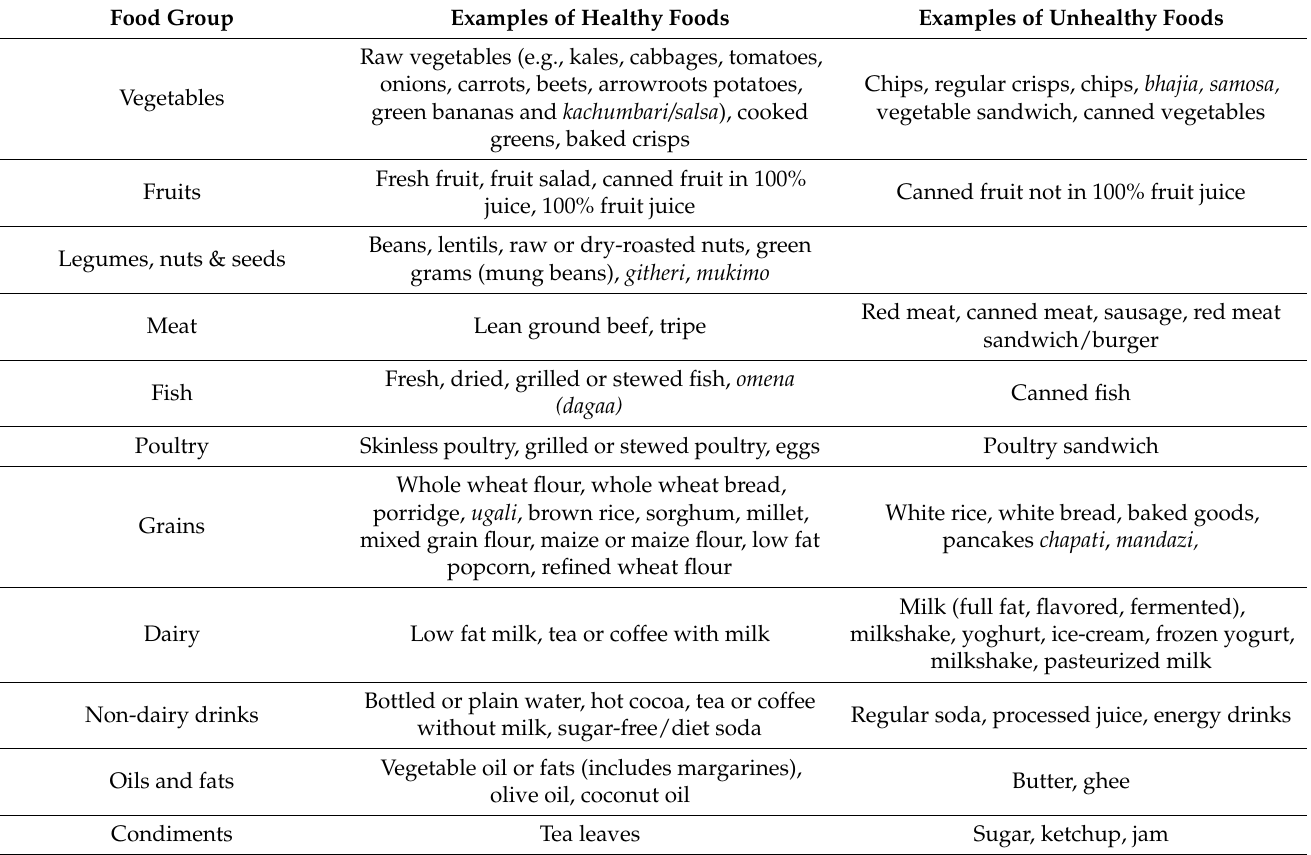
Table 1. Classifying foods into healthy and unhealthy food